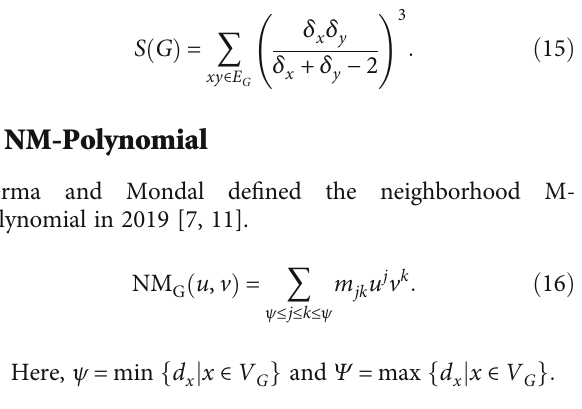
Table 1: Neighborhood degree dependent topological indices via NM-polynomial.